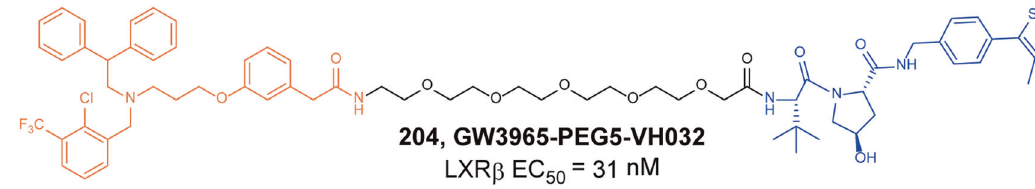
Fig. 59 The representative PROTAC targeting LXR- β